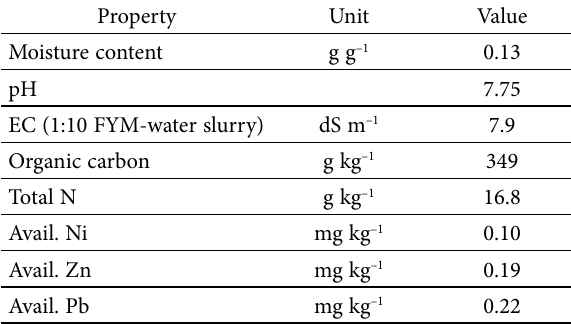
Table 2. Properties of farmyard